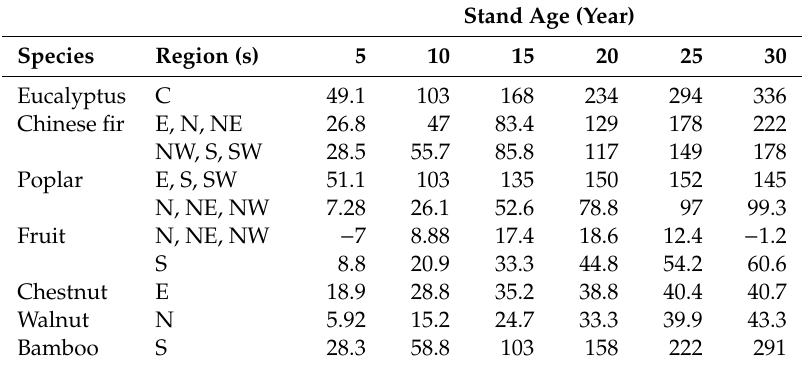
Table 4. Total carbon sequestration (Mg ha − 1 ) after a ff orestation with various species on cropland in di ff erent